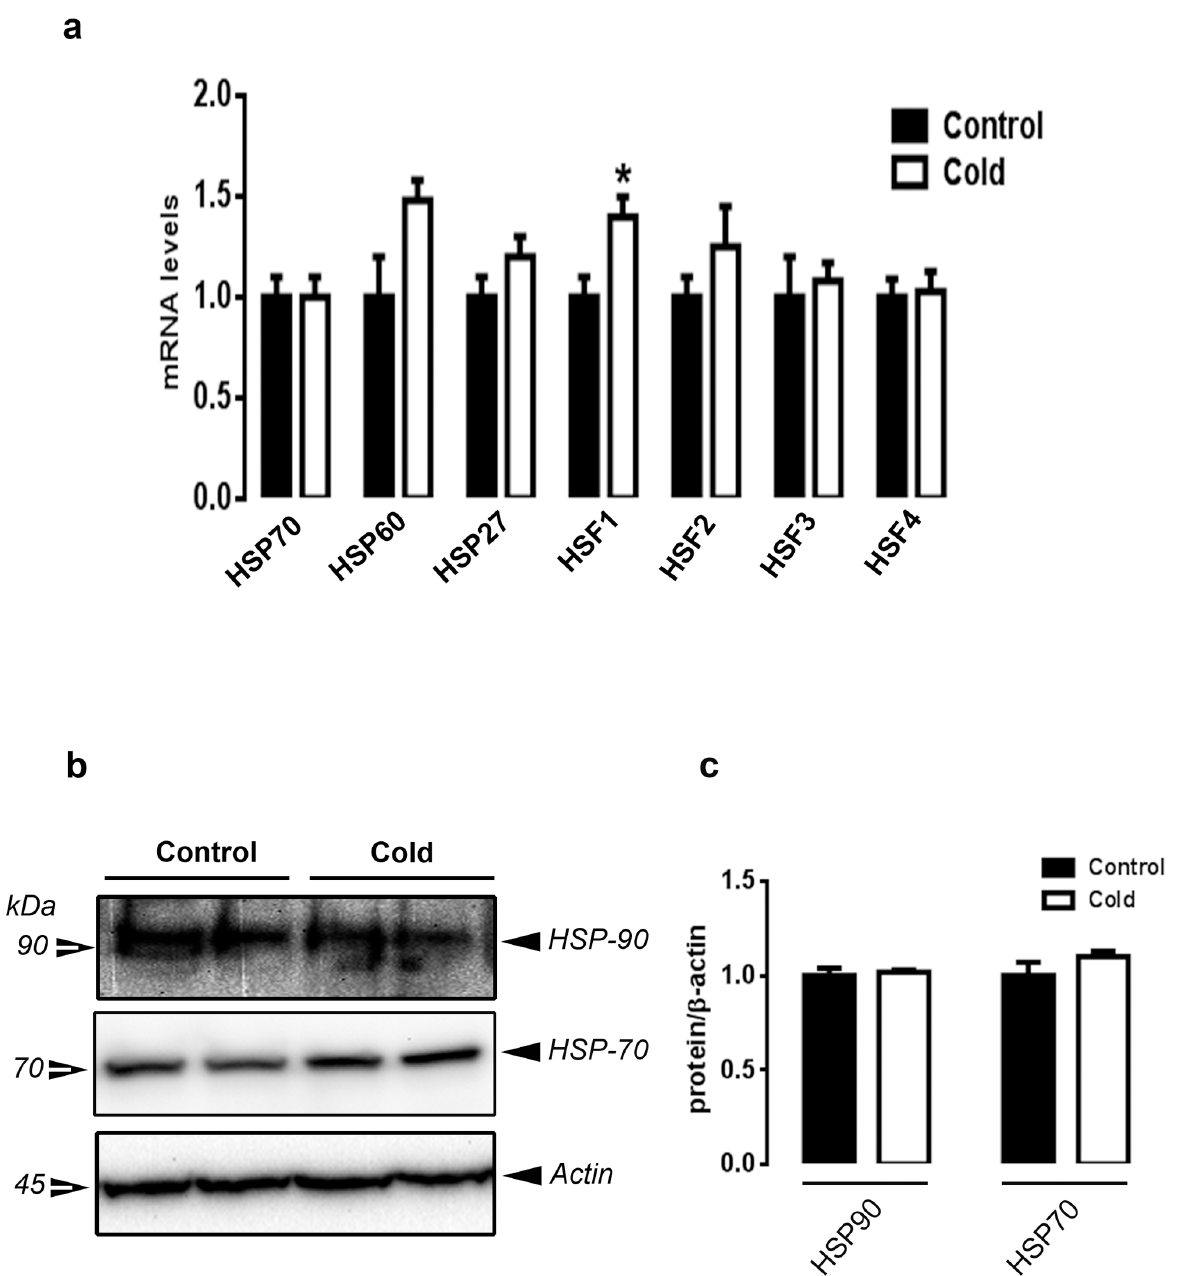
Fig 7. Effect of CMCC on HSP and HSF expression in the muscle of young broiler chicks. HSP and HSF mRNA levels were measured by qPCR (a). HSP70 and HSP90 protein levels were determined by Western blot (b) and presented as normalized ratio to β -actin (c). The values represent the mean ± SEM (n = 6). * Indicates a significant difference between cold and control group ( P <